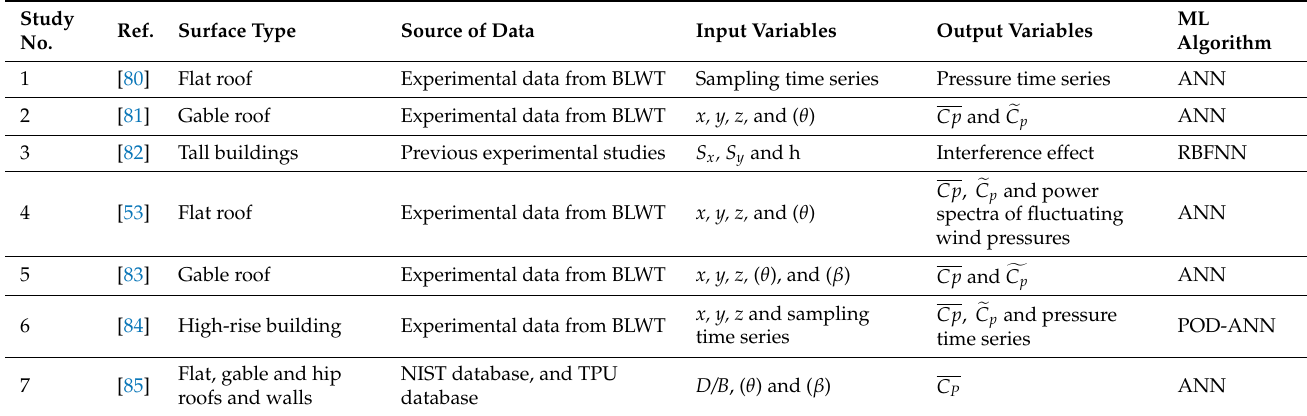
Table 1. Summary of studies reviewed for wind-induced